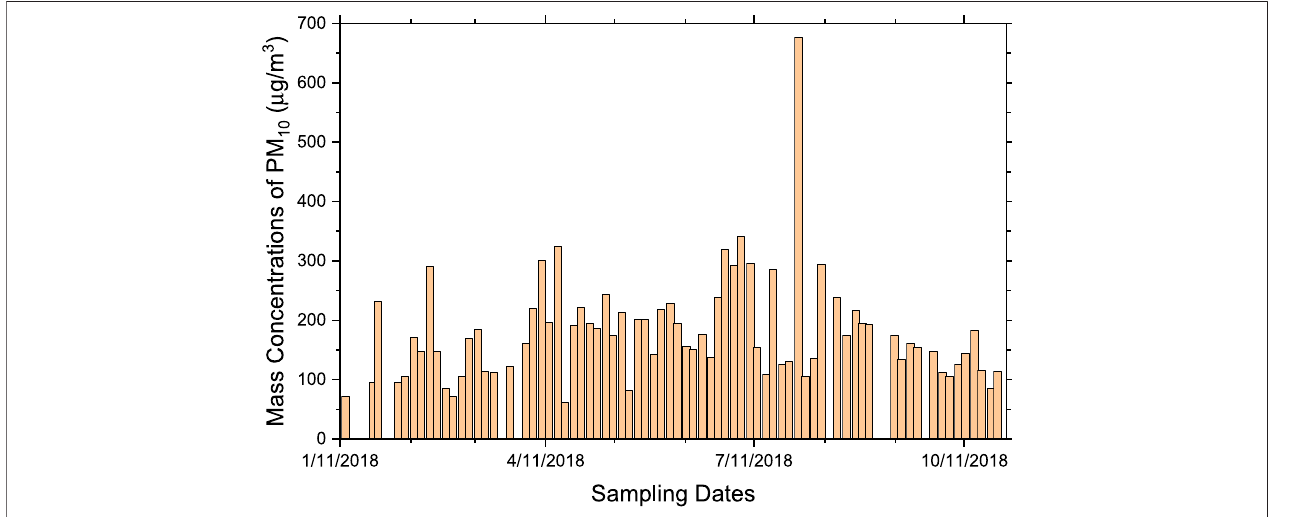
FIGURE 1 | Variation of the mass concentrations for PM 10 , collected over the sampling campaign period.